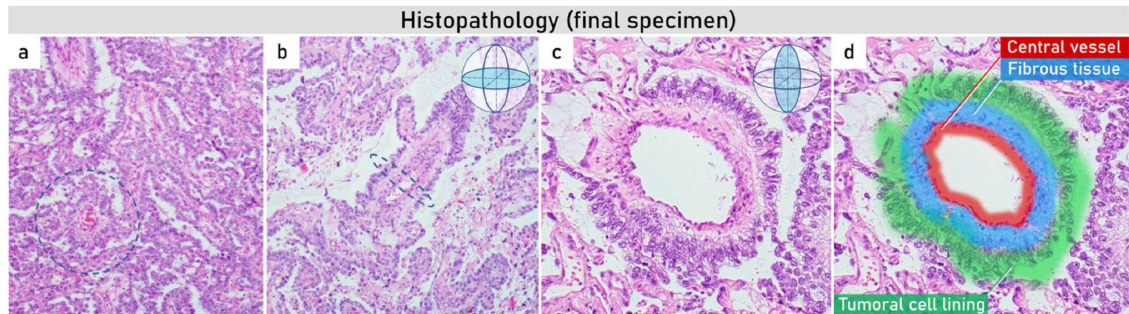
Figure 3. Histopathology (final specimen). The specimens ( a , b ) at 200 × g magnification demonstrate ( a ) papillary pattern combined with small tubopapillary endodermal sinus structure (Schiller–Duval body) in blue circle; ( b ) marked tubulopapillary sinusoidal structure with central vascular core in longitudinal section (Schiller–Duval body); ( c , d ) 400 × g magnified image plus zoom of diagnostic round cystic Schiller–Duval body in a transverse section, with microcystic and papillary patterns around. The body has a central vessel surrounded by fibrous tissue, called the fibrovascular core, and it is surrounded by layers of the tumoral cells at the surface of that stalk. The structure is located in open cystic space also lined by tumoral cells. All those structures together are called a Schiller–Duval body and resemble primitive